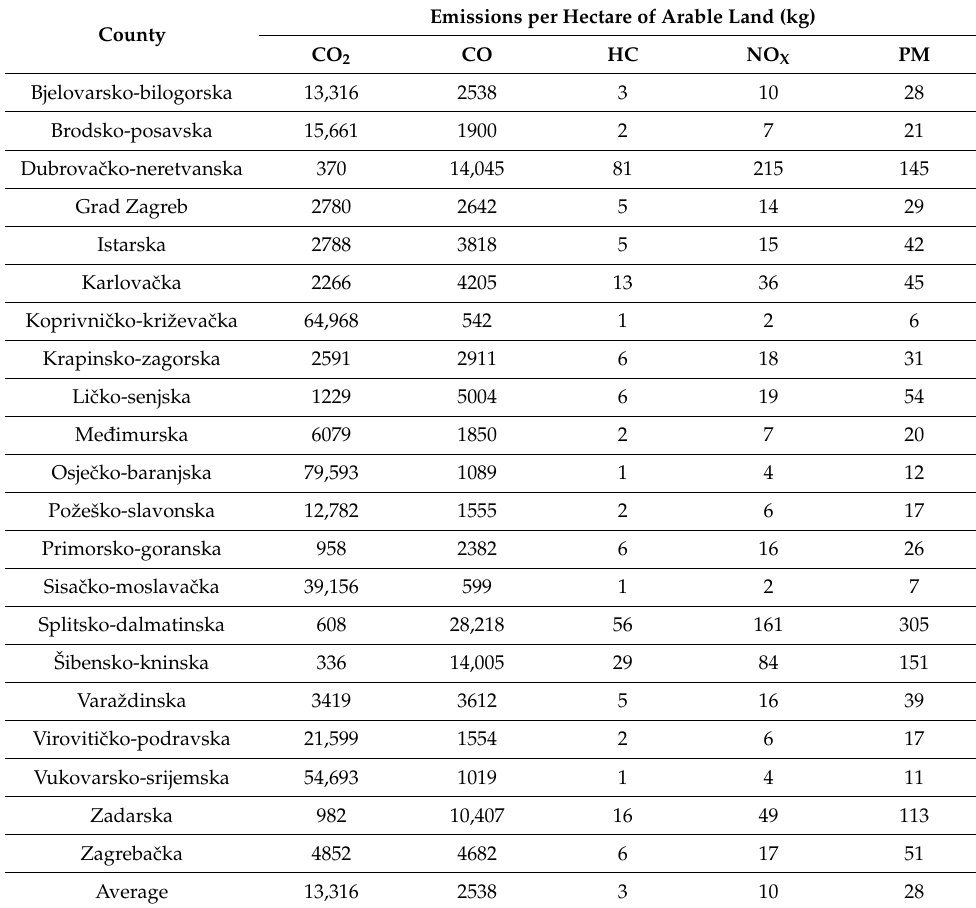
Table A2. Emissions of agricultural machinery per hectare of arable land by